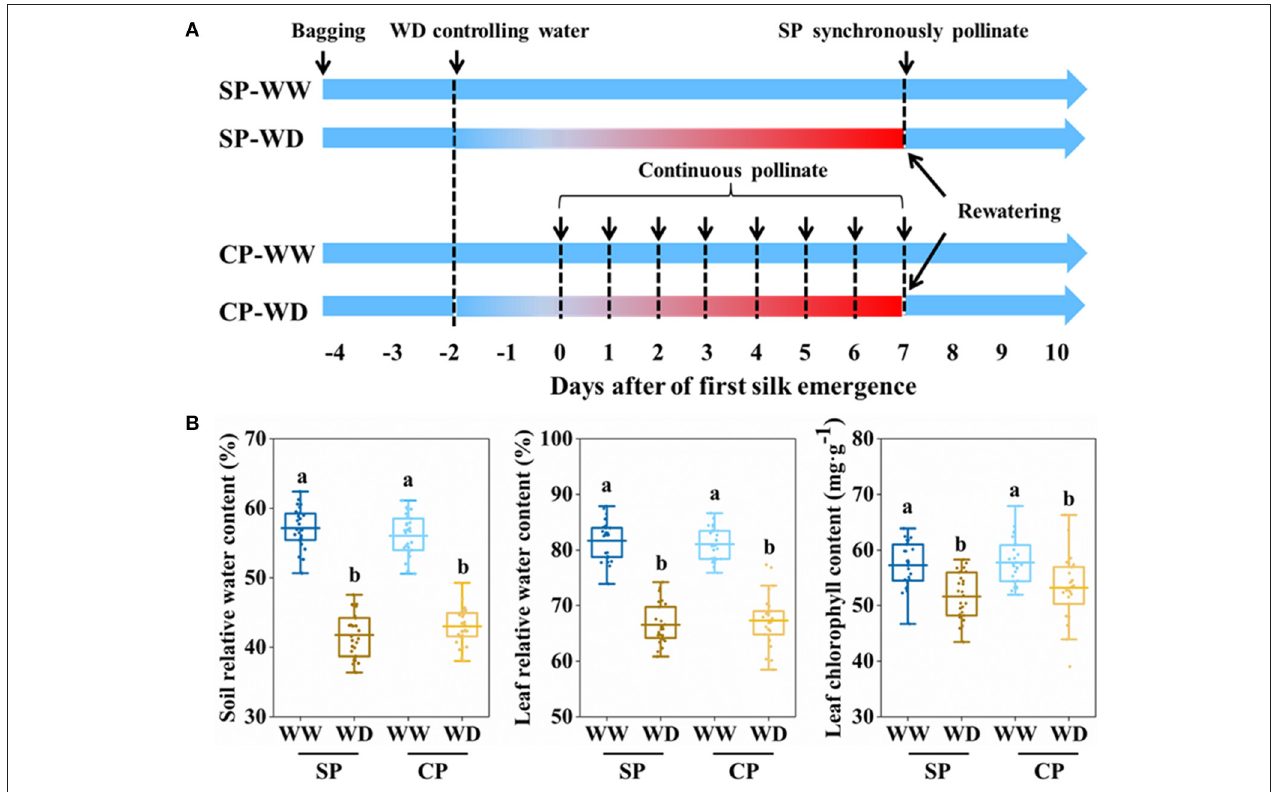
FIGURE 1 | Processes of manual pollination and control of soil water content. (A) Summary of the pollinatioin time and water control. (B) Soil relative water content, leaf relative water content, and leaf chlorophyll content in all treatments at 3 days after of first silk emergence. SP, synchronous pollination; CP, continuous pollination; WW, well-watered treatment; WD, water-deficit treatment. One-way ANOVA followed by Duncan’s new multiple range test, n ≥ 3; letters (a and b) indicate significant differences ( p <